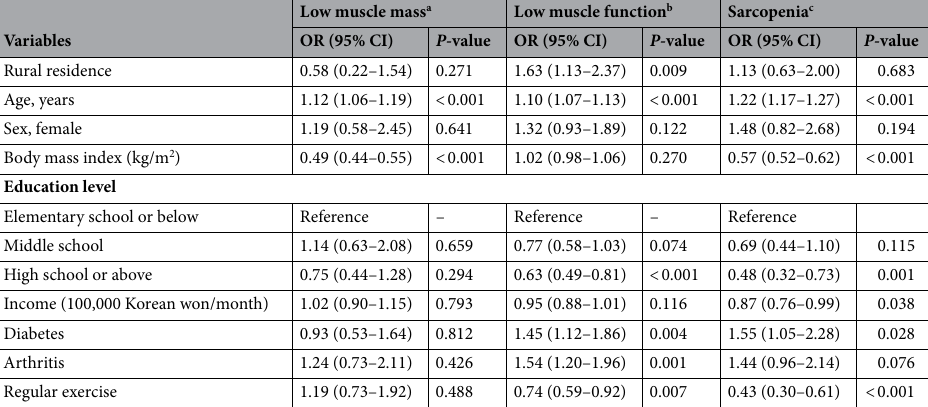
Table 3. Relationship between covariates and low muscle mass, low muscle function, and sarcopenia from the respective multivariate logistic regression analyses. Following covariates were included in the logistic regression model: regional difference, age, sex, body mass index, education level, marital status, monthly income, smoking status, regular physical activity, and past medical history (hypertension, diabetes, dyslipidemia, arthritis, cerebrovascular accident, angina or myocardial infarction, and malignancy). OR odds ratio, 95% CI 95% confidence interval. a Following participants are included in the analysis: normal muscle mass and function group and low muscle mass group. Appendicular lean mass/height 2 < 5.7 kg/m 2 in female and appendicular lean mass/height 2 < 7 kg/m 2 in male. b Following participants are included in the analysis: normal muscle mass and function group and low muscle function group. Handgrip strength < 18 kg in female and < 28 kg in male and/or 5-time chair standing test > 12 s. c Following participants are included in the analysis: normal muscle mass and function group and sarcopenia